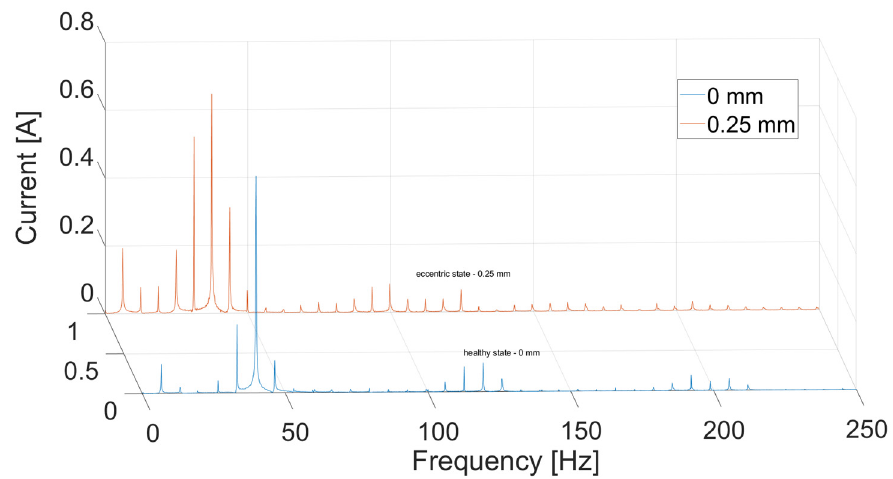
Figure 6. Phase current measured on test bench in frequency domain .